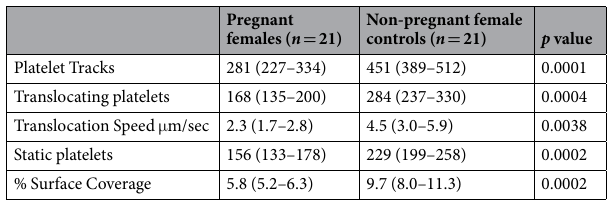
Table 2. Pregnancy induces a dramatic decrease in platelet interactions with VWF. Values show mean + 95%